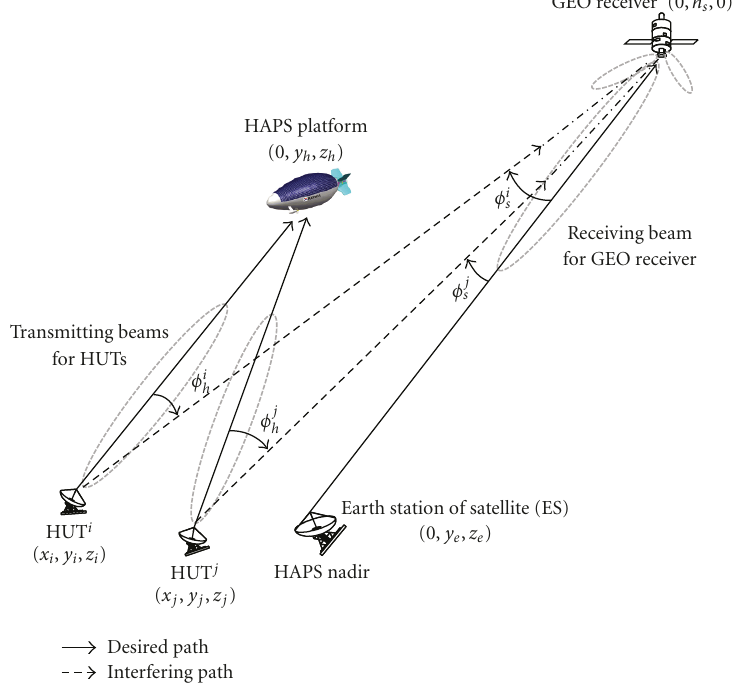
Figure 5: Geometric configuration for interference